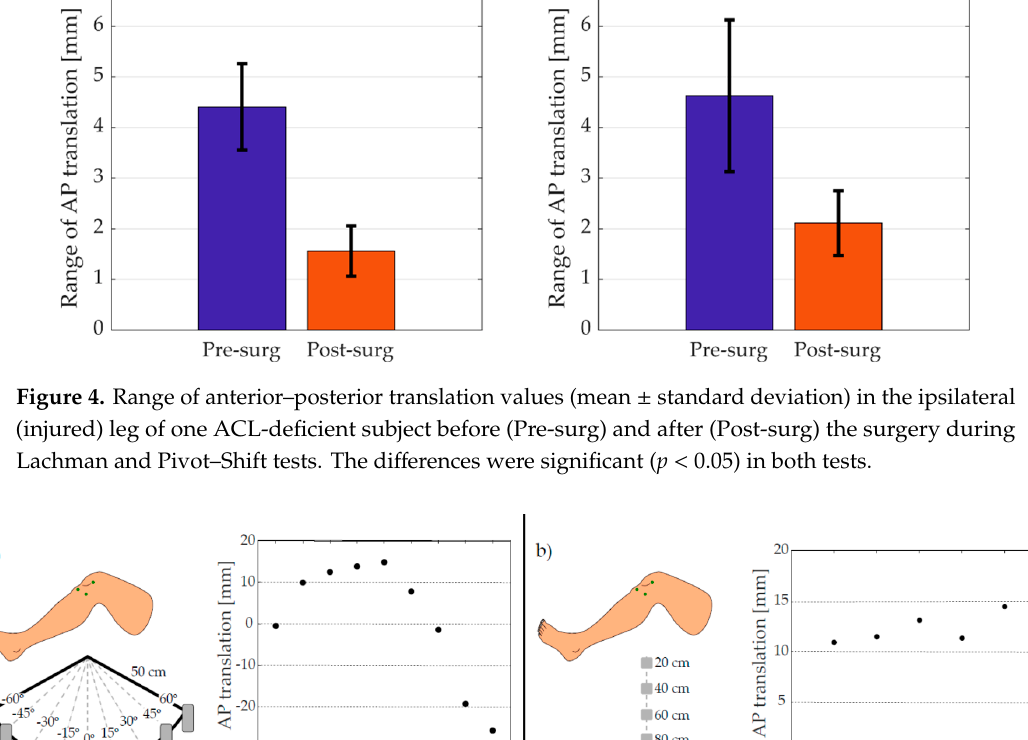
Figure 4. Range of anterior–posterior translation values (mean ± standard deviation) in the ipsilateral